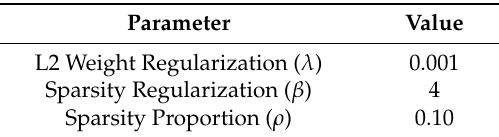
Table 2. Parameters of